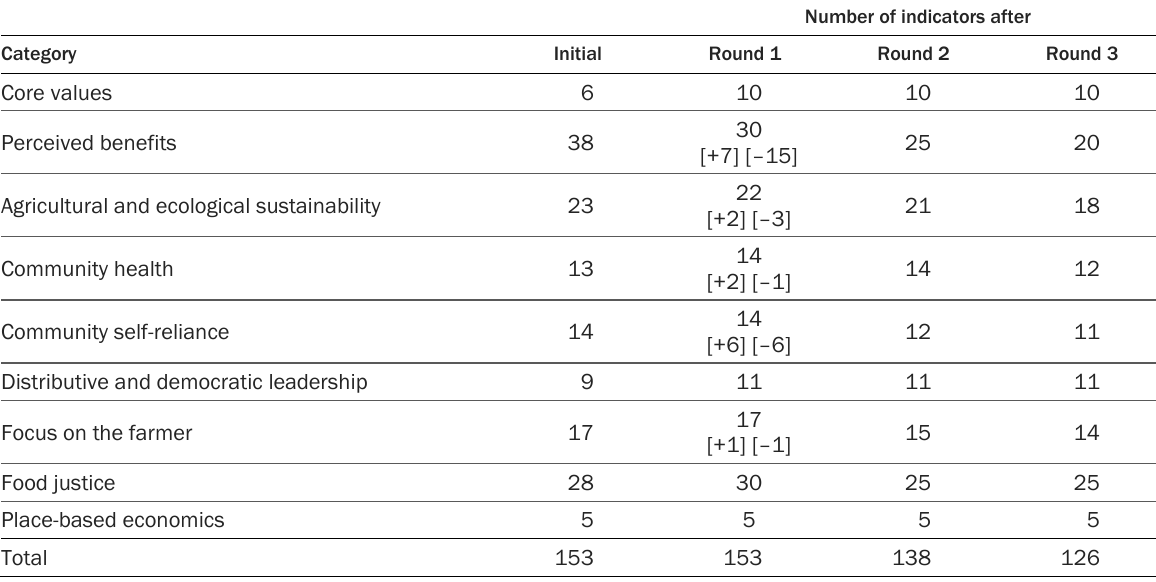
Table 1. Summary of Indicators by Category and